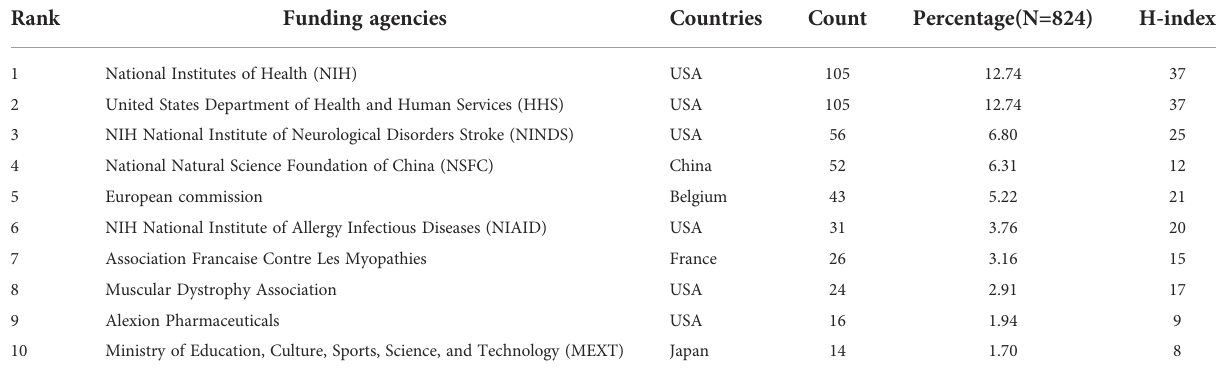
TABLE 3 The top 10 funding agencies contributed to targeted immunotherapy for MG.